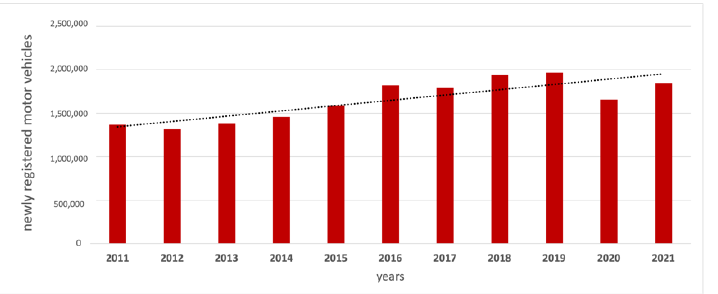
Figure 1. Number of newly registered motor vehicles in Poland for the years 2011 – 2021